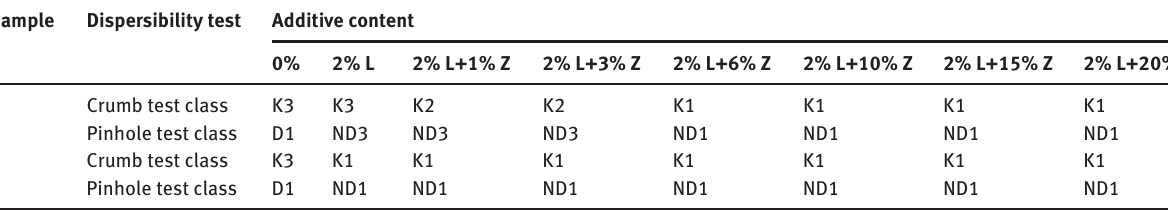
Table 4: Results of dispersibility tests performed on the samples mixed with different additive contents.